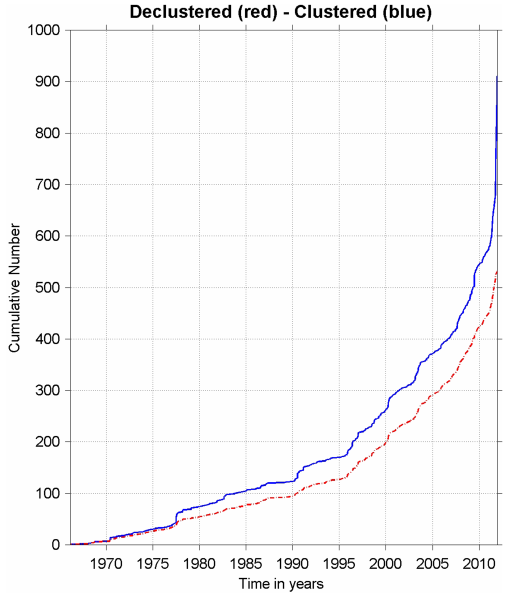
Fig. 3. Cumulative seismicity curves of the Santorini region as a function of time. Clustered (blue curve) vs. Declustered (red curve).